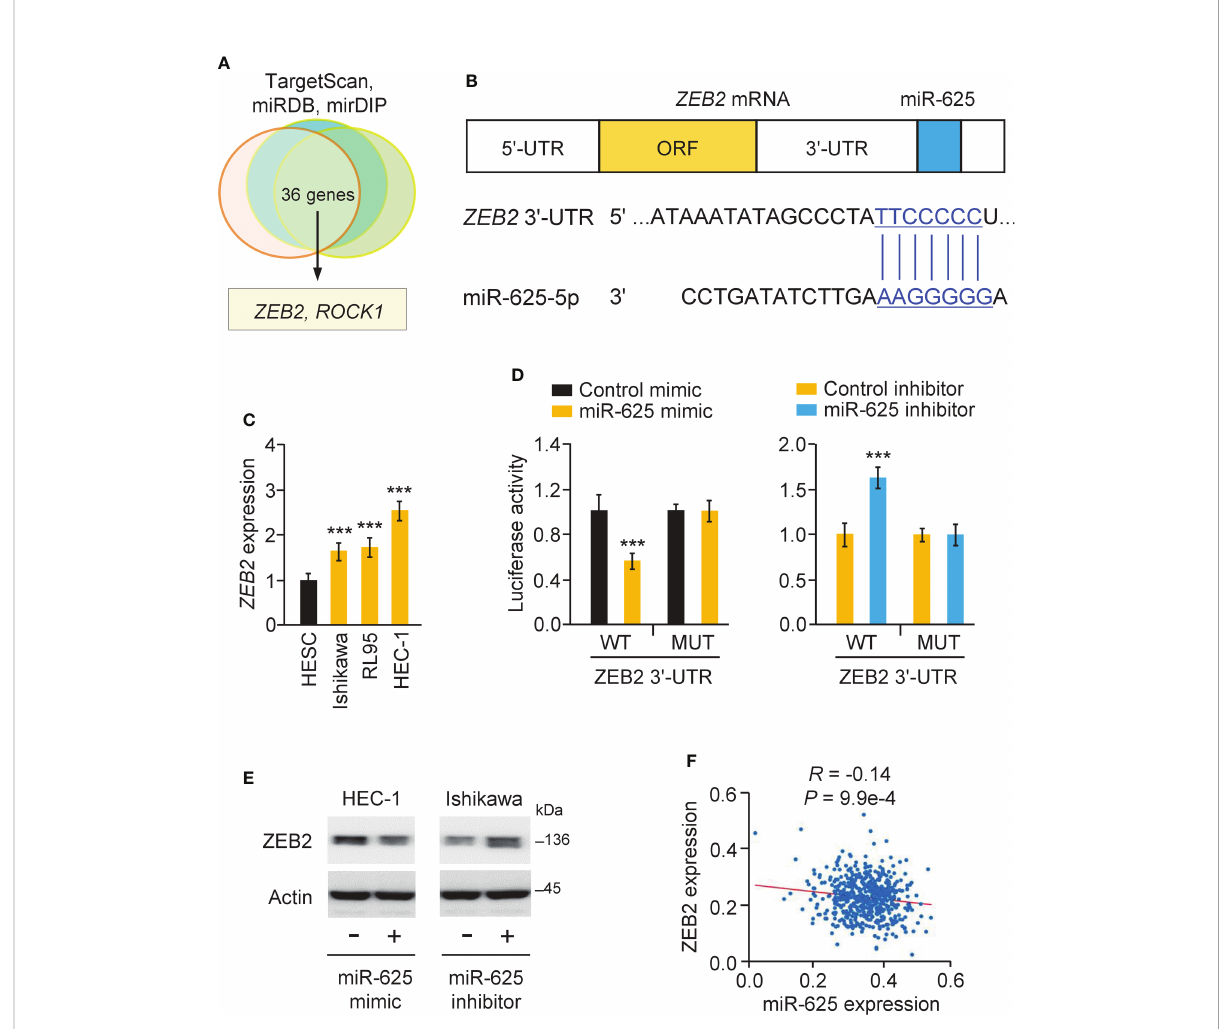
FIGURE 7 MiR-625 targets ZEB2 in endometrial cancer cells. (A) Venn analysis of predicted miR-625 target genes. (B) The luciferase reporter plasmids contained wild-type (WT) and mutated (MUT) miR-625 binding sites in the ZEB2 3´-UTR sequence. (C) ZEB2 mRNA expression in endometrial cancer cells and normal cells. (D) Luciferase reporter assay of endometrial cancer cells transfected with miR-625 mimic, miR-625 inhibitor, and luciferase reporter plasmids containing WT or MUT ZEB2 3´-UTR. (E) Western blot analysis of ZEB2 and actin expression in endometrial cancer cells transfected as indicated. (F) The correlation between miR-625 and ZEB2 expression in TCGA endometrial cancer samples. *** P <